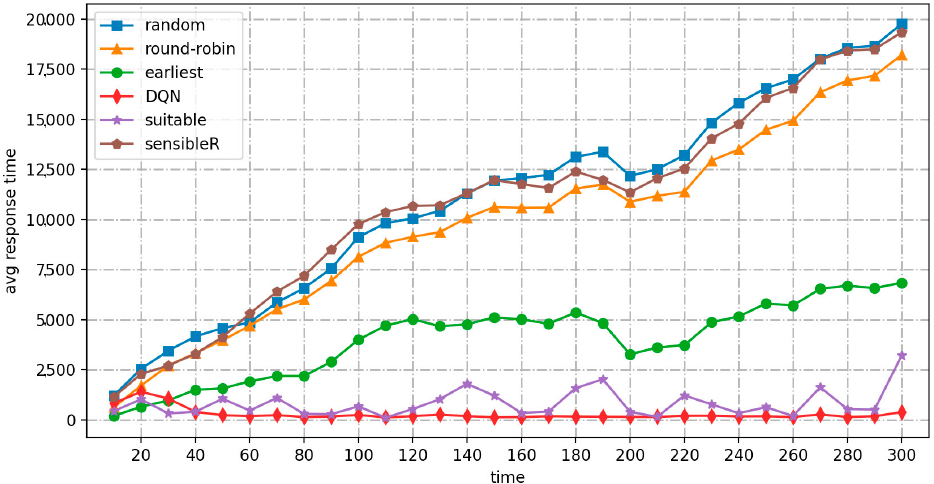
Figure 12. Average response time in high-frequency workload mode.